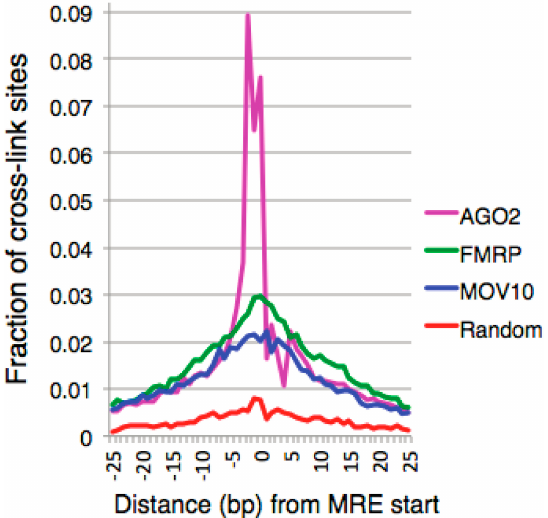
Figure 3. Spatial analysis of CLIP sites of miRNA-associated proteins in the 3 ′ UTR of target mRNA. Overlay of MOV10 (blue), Argonaute 2 (AGO2) (pink), and FMRP (green) crosslink sites plotted against distance in base pairs to predicted MRE start site. Random sites in random genes were selected as a control (red). The close proximity of CLIP binding sites suggest an interactive role of the proteins on the 3 ′ UTR of co-bound mRNA [49].